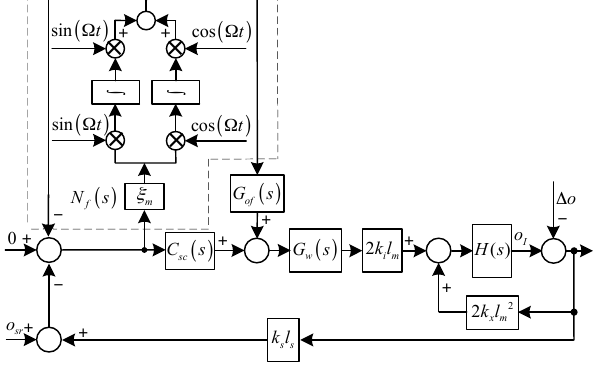
Figure 4. Diagram of the rotational system with synchronous torque elimination.